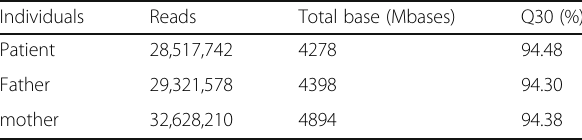
Table 3 Sequencing outputs in patient and both parents